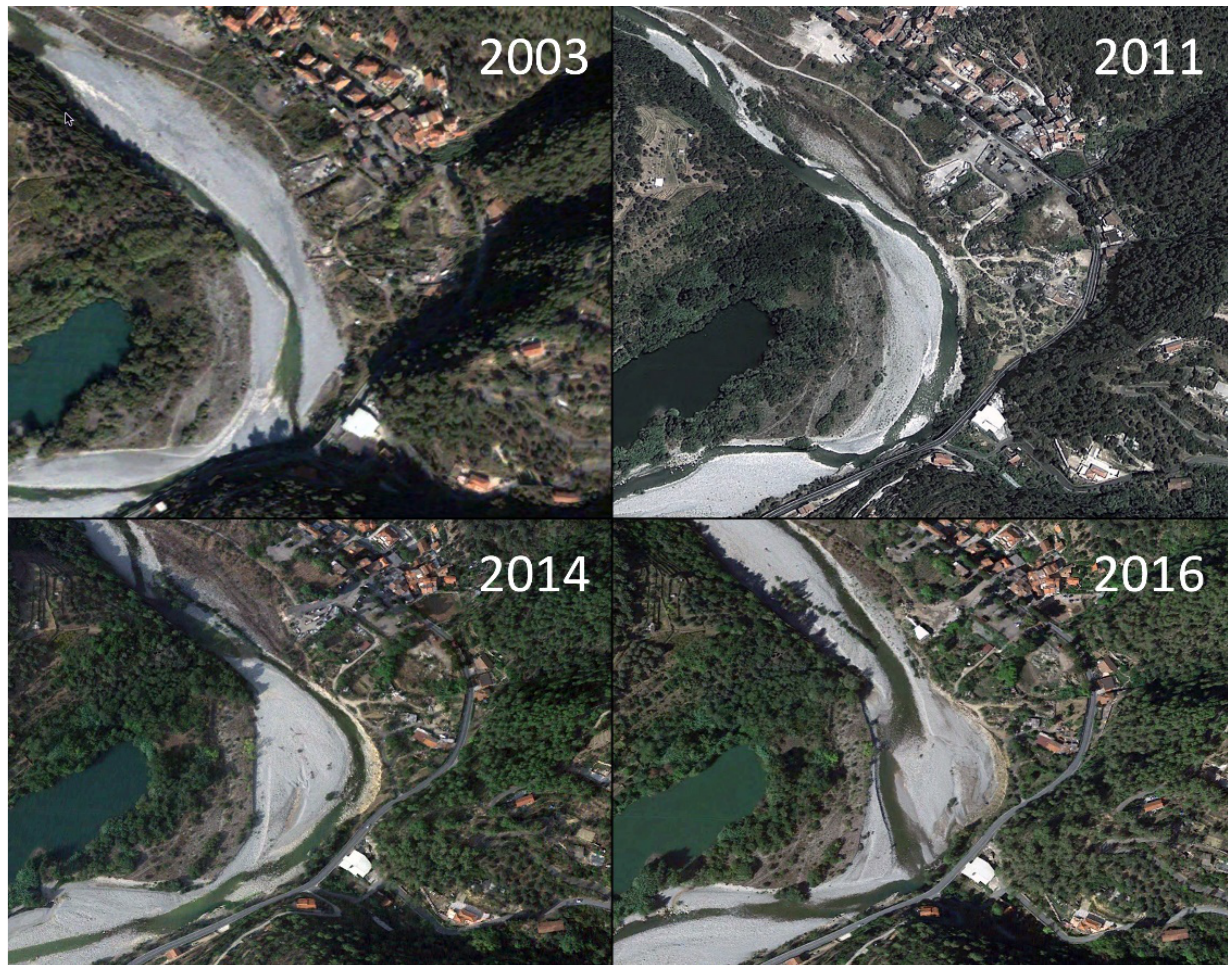
Figure 11. Temporal reconstruction of the channel in Figure 9A. (Images from Google Earth.)